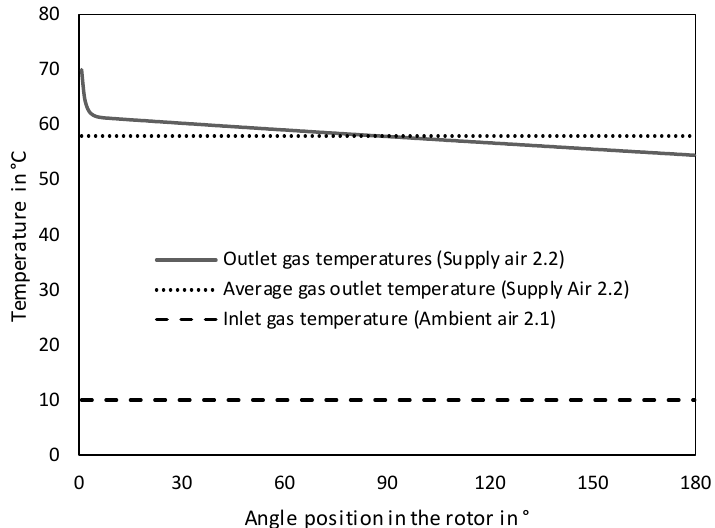
Figure 5. Simulated outlet temperatures and average outlet temperature for the gas phase in the cold sector.